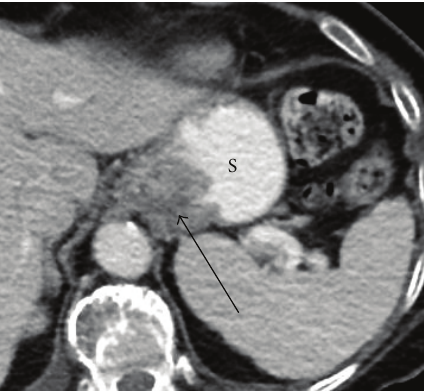
Figure 1: A CT slice of the left upper abdomen showing a large filling defect (arrow) with thickened folds at the cardia of the stomach (S).